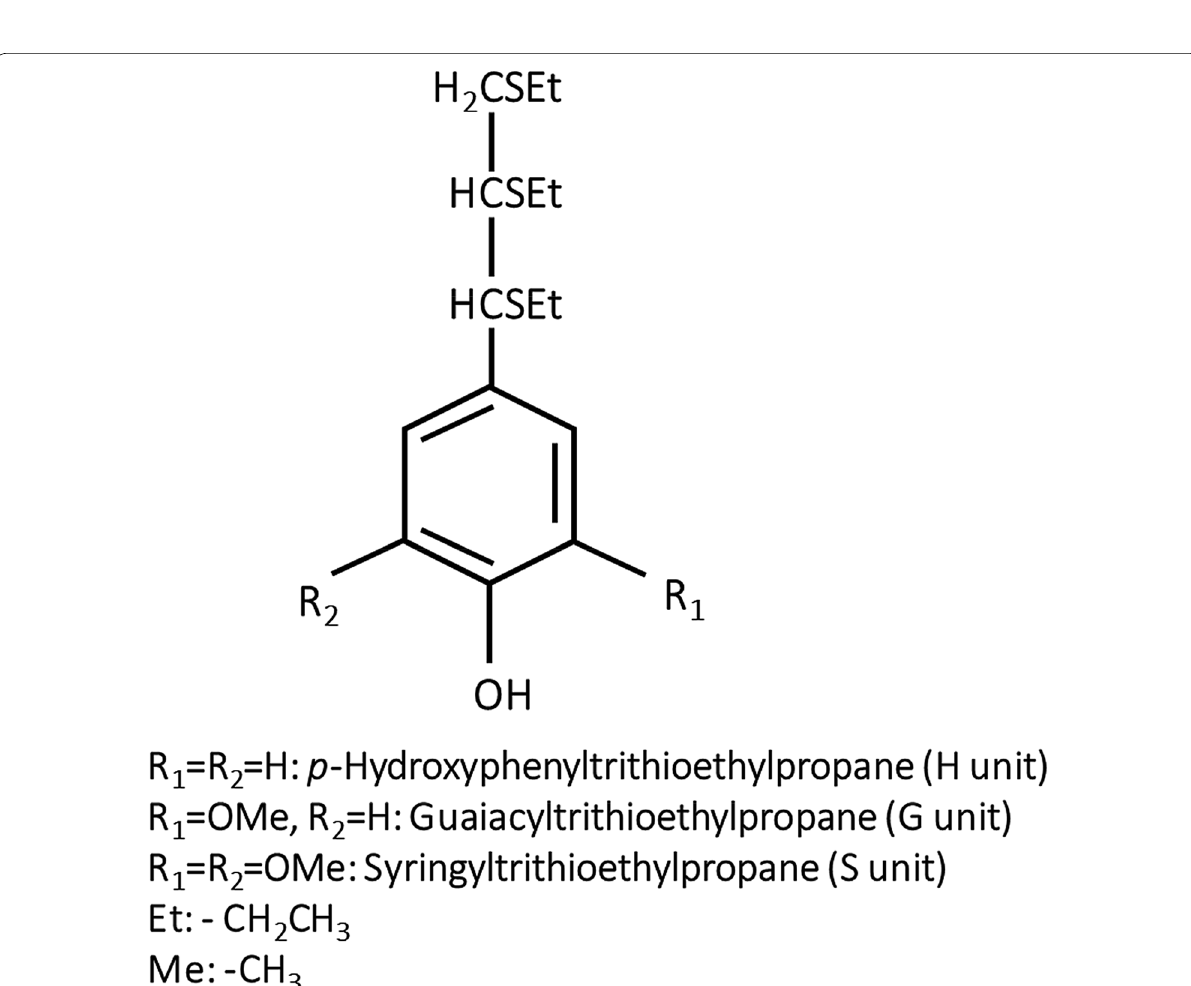
Fig. 2 Major products obtained by the thioacidolysis of native